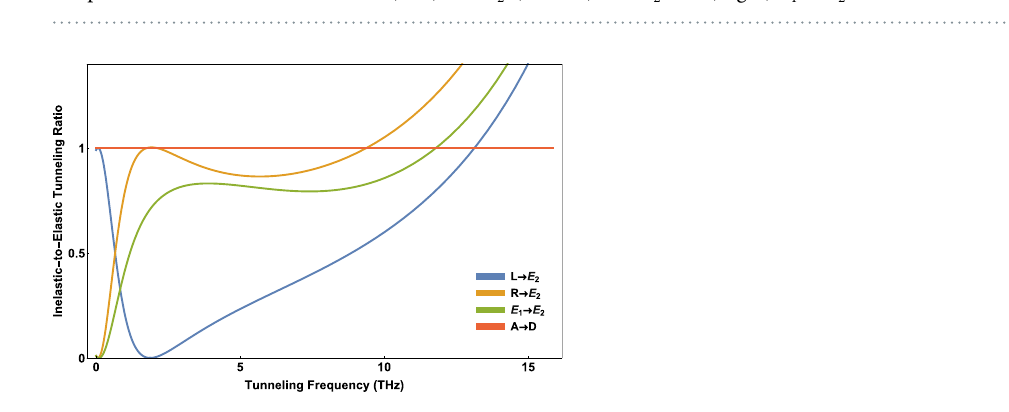
Figure 3. The inelastic-to-elastic ratio versus tunneling frequency ω x and asymmetry frequency ω x at biological temperature T = 310 K for transitions (Left) L → E 2 , (Middle) R → E 2 , and (Right) E 1 → E 2 .